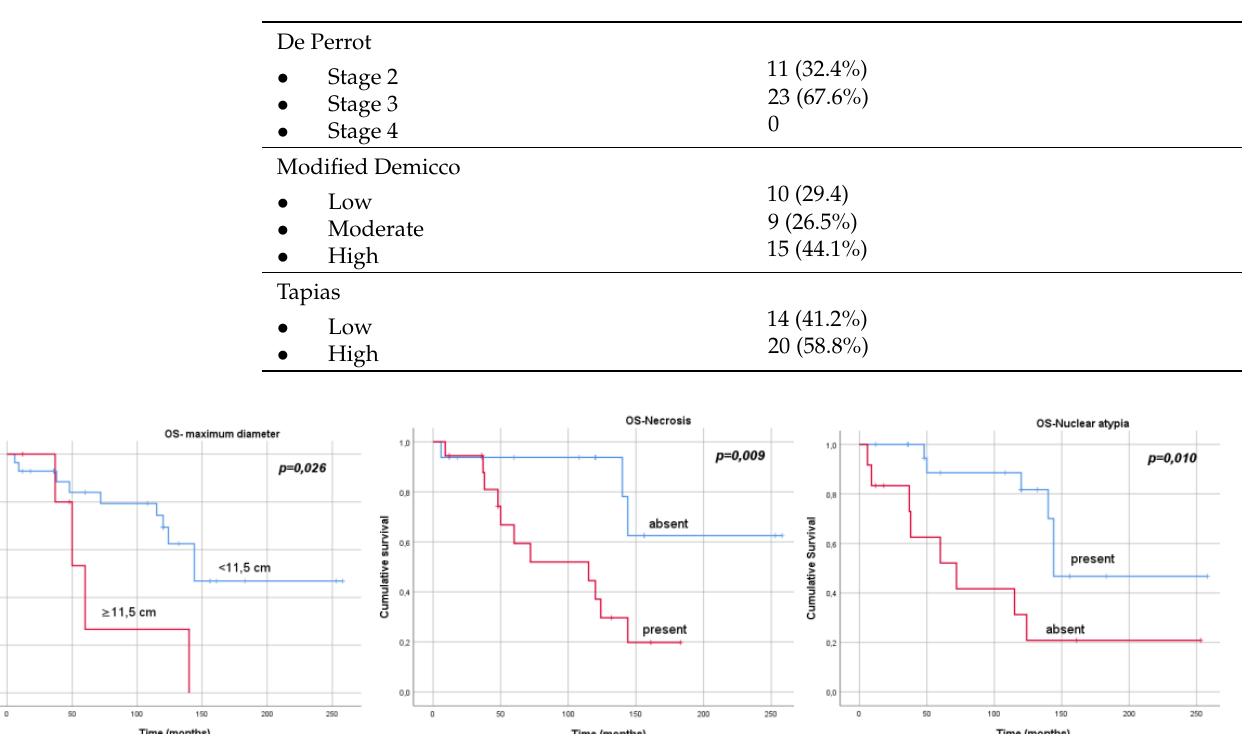
Table 4. Risk stratification assessment.